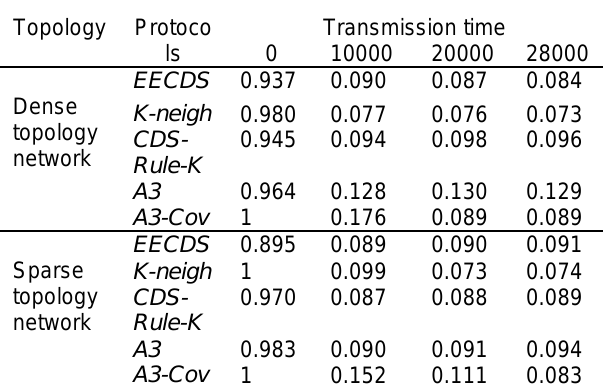
Table 5. Experiment 1: Number of active nodes